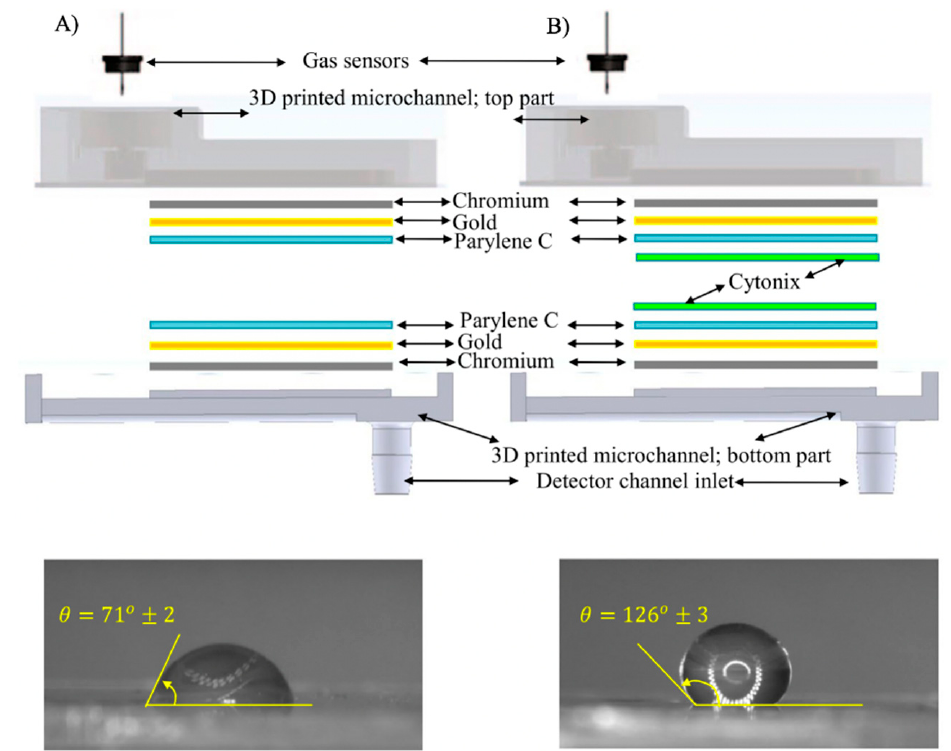
Figure 12. Multilayer coating of a microfluidic channel: ( A ) three-layer coating with chromium, gold, and Parylene C and ( B ) four-layer coating adding Cytonix, a highly hydrophobic material that enhances interaction with nonpolar analytes. Reprinted from ref. [262]. Copyright 2019, Springer Nature.